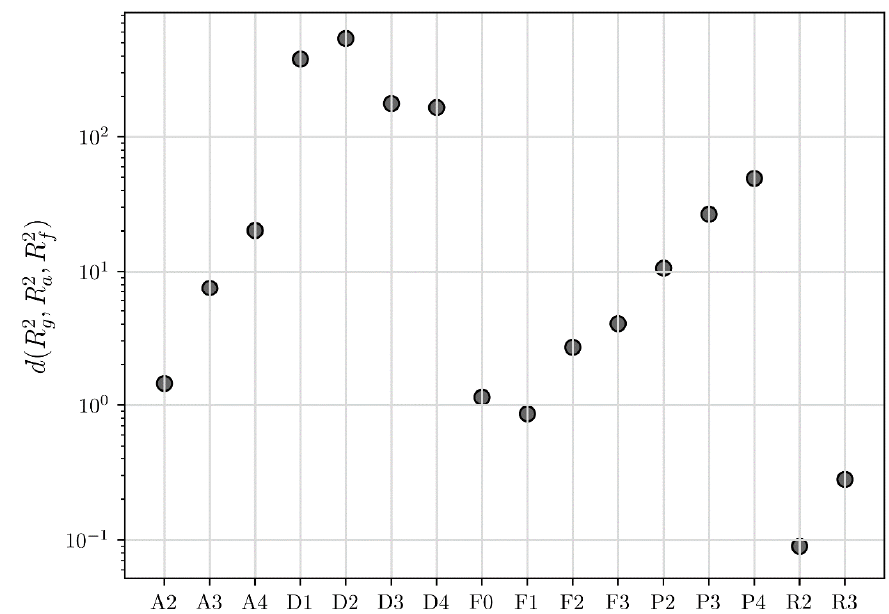
Figure 8. The calculated Euclidean distances via the COMF method for all the models presented in Table 1 in the case of the desolvation of the methanol solvates of ciclesonide at 115 °C